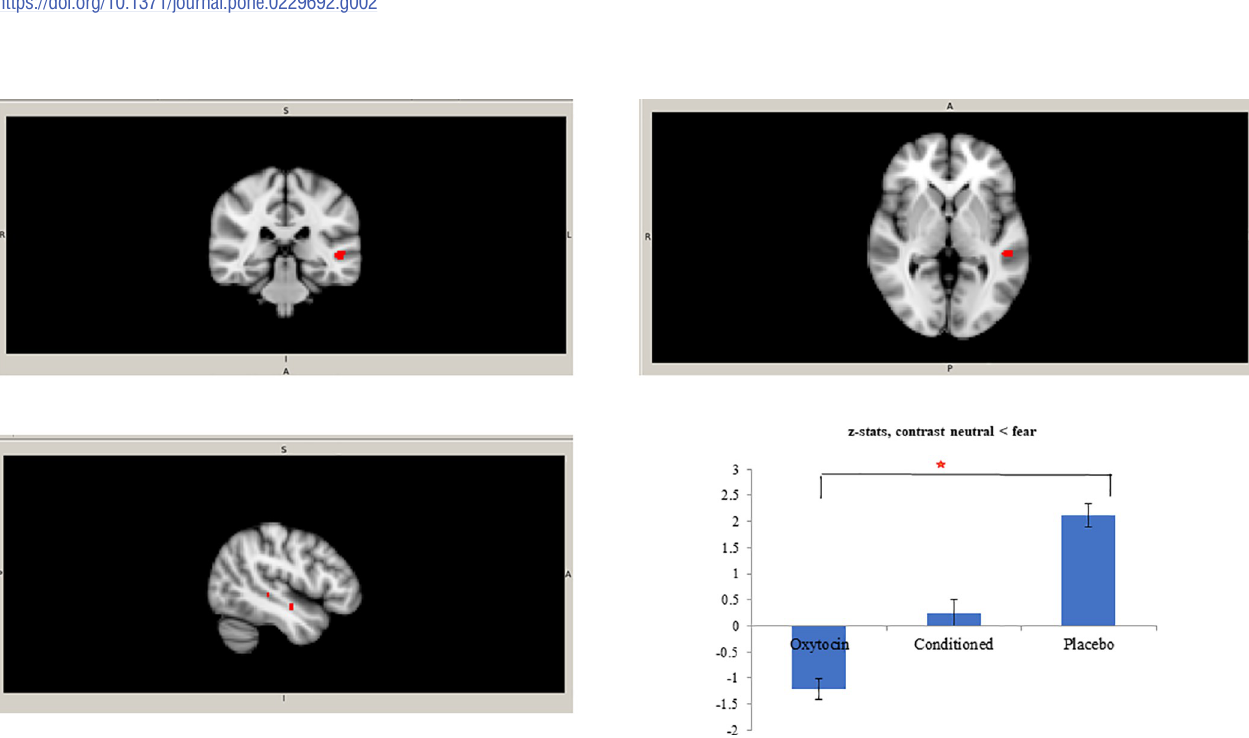
Fig 3. Clusters in left superior temporal gyrus, contrast neutral < fearful. Clusters in the left superior temporal gyrus (cluster 1: -50, -32, 0; t max = 4.23, cluster size = 41; cluster 2: -46, -10, -12; t max = 4.84; cluster size = 14) with the significantly lower activation in the oxytocin group in comparison to the placebo group on the contrast neutral < fearful and mean Z statistics with standard deviations from these clusters.